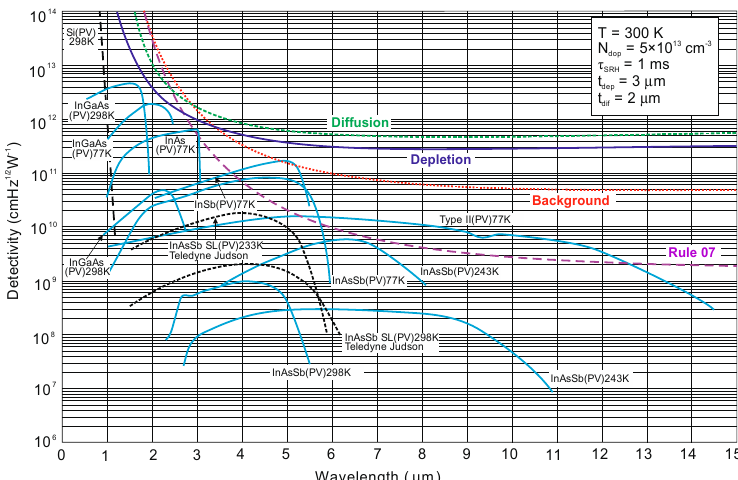
Figure 45. Spectral detectivity curves of commercially available photovoltaic (PV) detectors at different temperatures (after [140]). The theoretical curves are calculated for P-i-N HOT HgCdTe photodiodes assuming the value of τ SRH = 1 ms, the absorber doping level of 5 × 10 13 cm − 3 , and the thickness of active region t = 5 μ m [119].